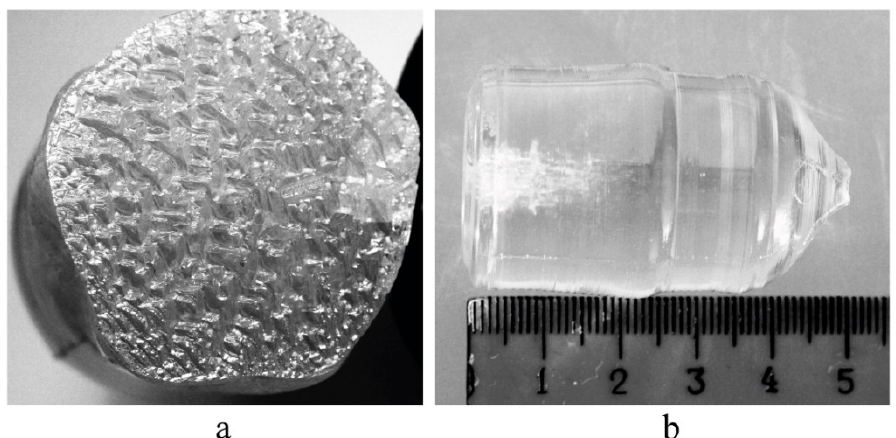
Figure 3. ( a )—cellular growth in the bottom of the LiNbO 3 :B boule grown using technological parameters typical for the growth of LiNbO 3 :Me (Me: Zn, Mg) crystals; ( b )—change in the diameter of the LiNbO 3 :B crystalline boule due to changes in thermal conditions at the crystallization front.